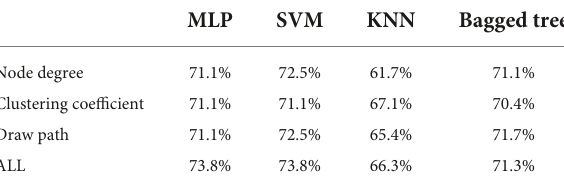
TABLE 3 Binary classification emotion recognition results based on